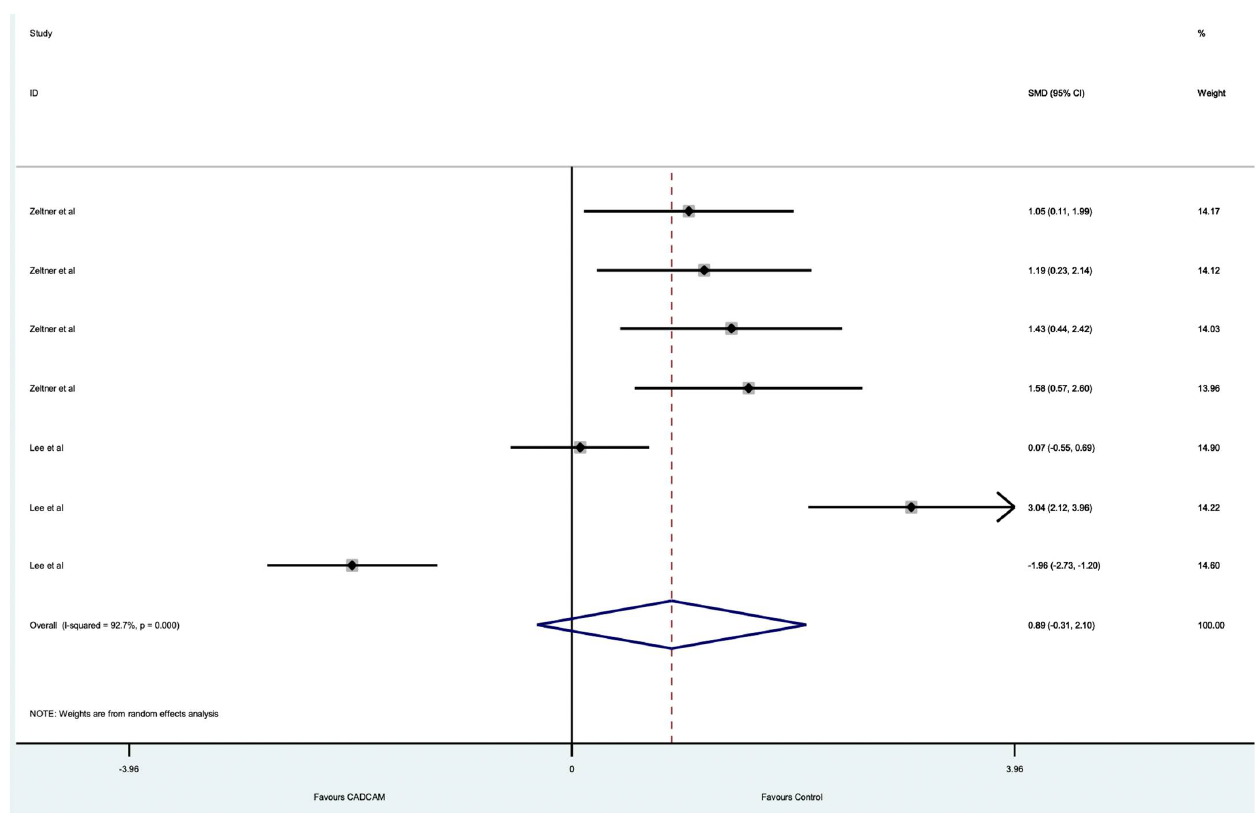
Figure 6. Forest plot of included studies investigating the internal fit of crowns.